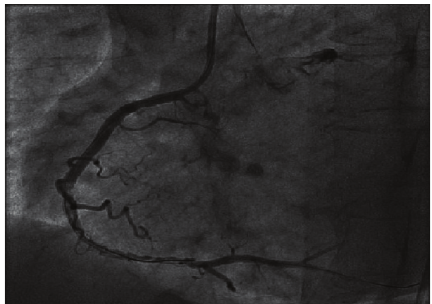
Figure 5: Right coronary artery and TIMI III flow after floppy guidewires.